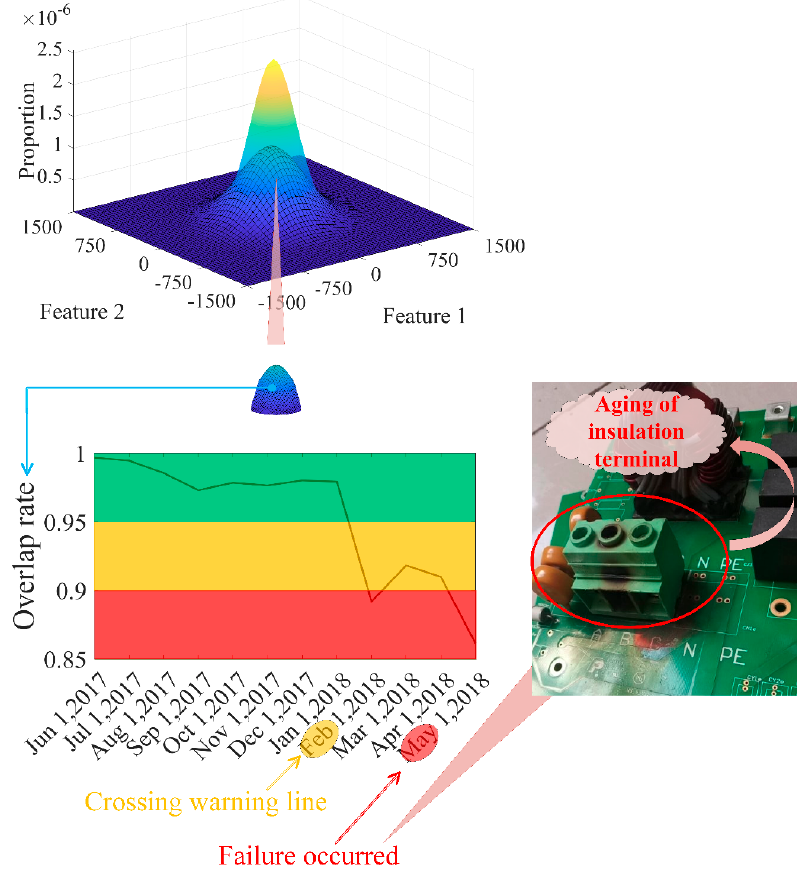
Figure 13. Fault prognostics for inverter 7 using the overlap rate.